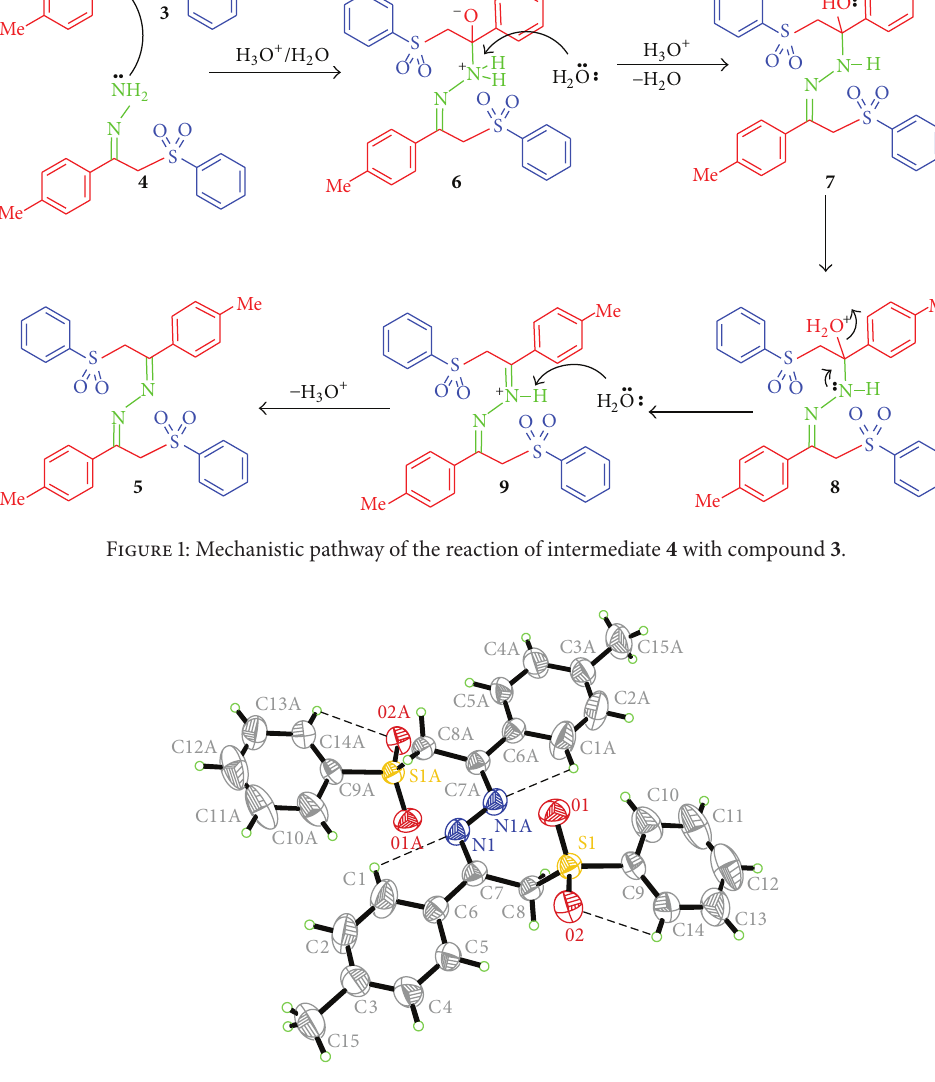
Figure 2: ORTEP diagram of compound 5 40% probability ellipsoid, showing intramolecular hydrogen